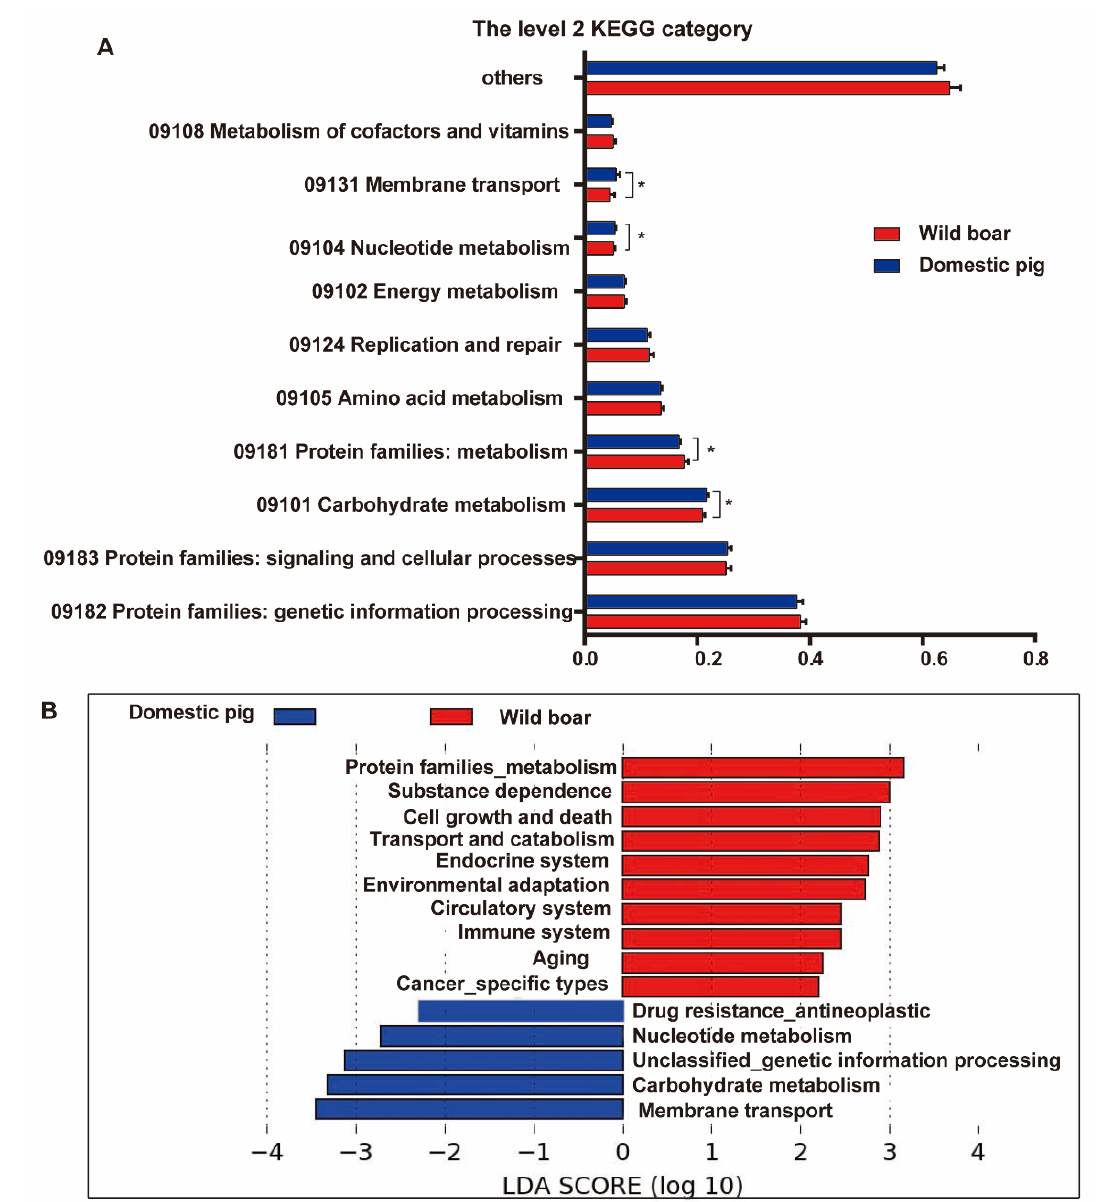
Figure 4. Top 10 KEGG categories and the LEfSe analysis between wild boars and domestic pigs. ( A ): Top 10 composition of KEGG category. The red bars and blue bars represent wild boars and domestic pigs, respectively. Whitney U-test, * p < 0.05. ( B ): The LEfSe analysis between wild boars and domestic pigs. The red bars and blue bars represent wild boars and domestic pigs, respectively. p < 0.05, LDA cutoff =